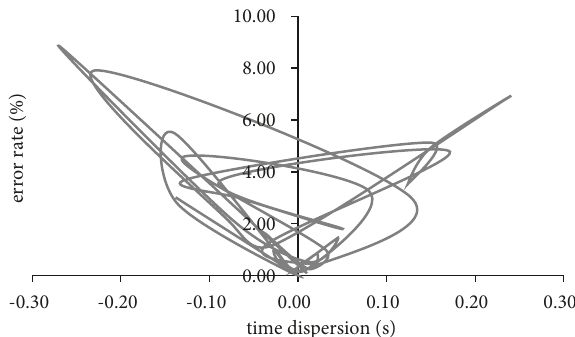
Figure 5: Diagram of the deviation and error ratio of the model parameter calibration